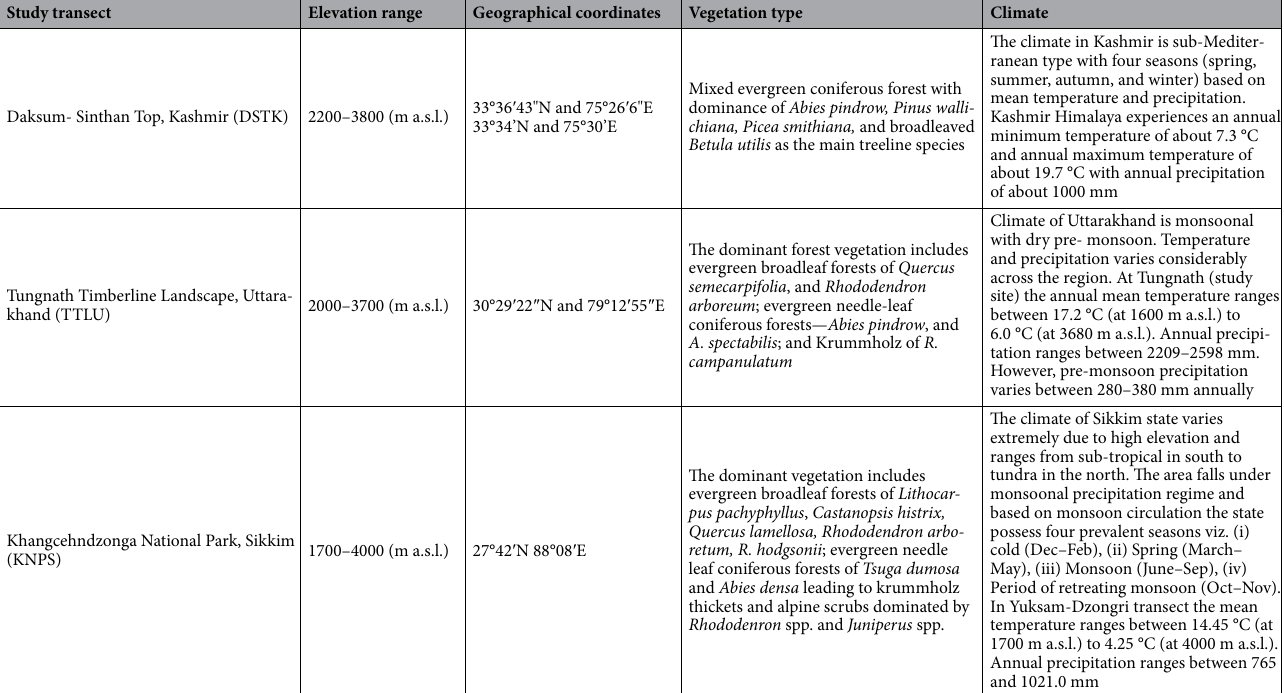
Table 1. Geographical location and other characteristics of elevation